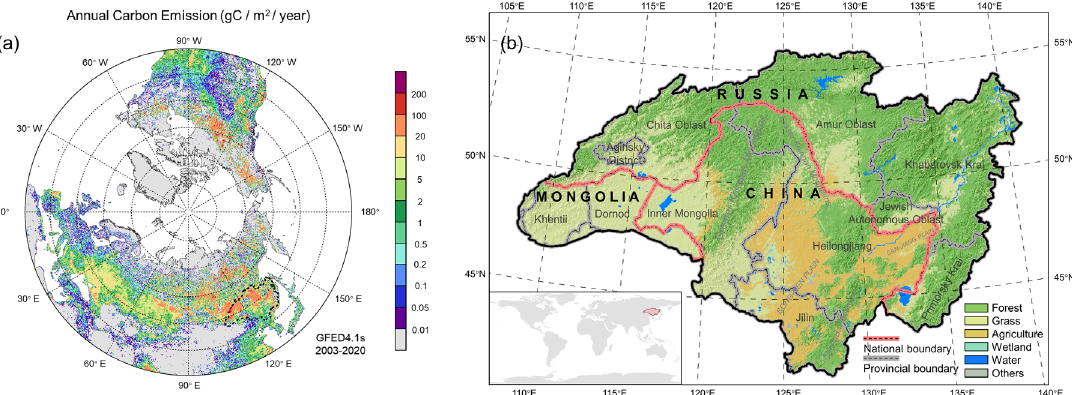
Figure 1. ( a ) Carbon emissions from biomass burning in the northern hemisphere (GFEDv4.1s); ( b ) land use and cover reclassification data in the Amur-Heilong River Basin in this study (MCD12Q1_IGBP, 2010).